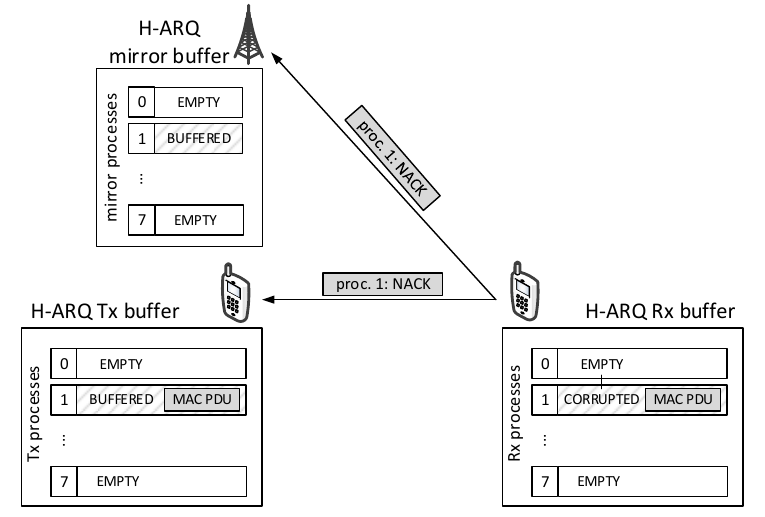
Figure 11. Example of H-ARQ buffer mirroring.